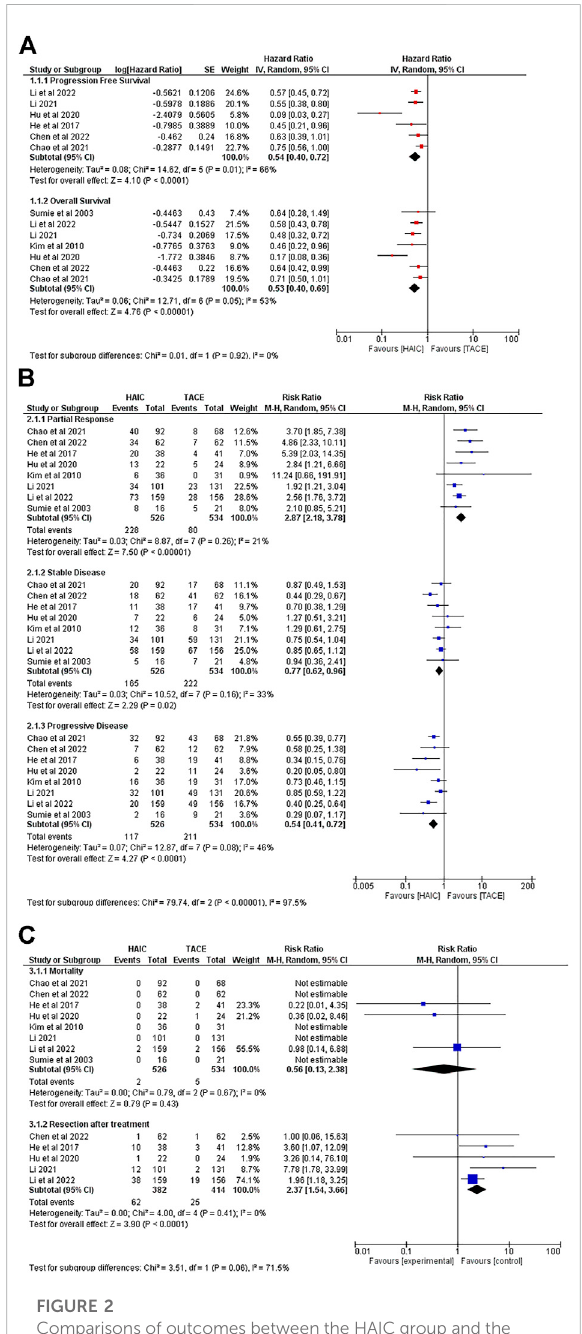
FIGURE 2 Comparisons of outcomes between the HAIC group and the TACE group. (A) . Forest plots of survival; (B) Forest plots of tumour response after treatment; (C) Forest plots of mortality and the rate of resection after